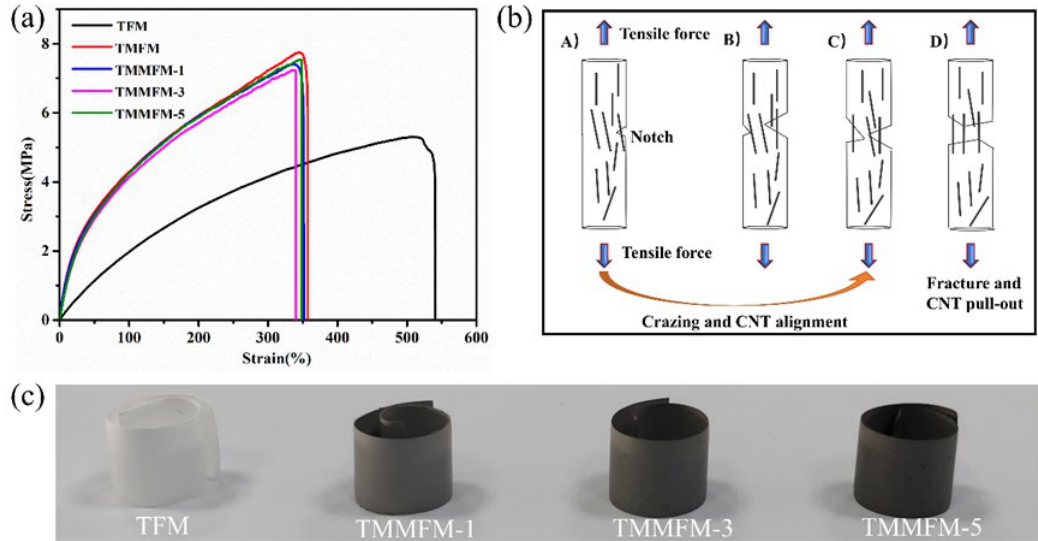
Figure 4. ( a ) Representative stress – strain curves of TFM, TMFM and TMMFM. ( b ) Schematic. diagram of the fracture process of TMFM. ( A ) Notches form as a result of tensile force, ( B ) notches are stretched at the crazing area, ( C ) crazing extends across the fibers with CNTs well aligned and ( D ) crazing fibers are broken. CNTs reinforce the fiber by pull-out from the TPU matrix. ( c ) Digital images of TFM and TMMFM.